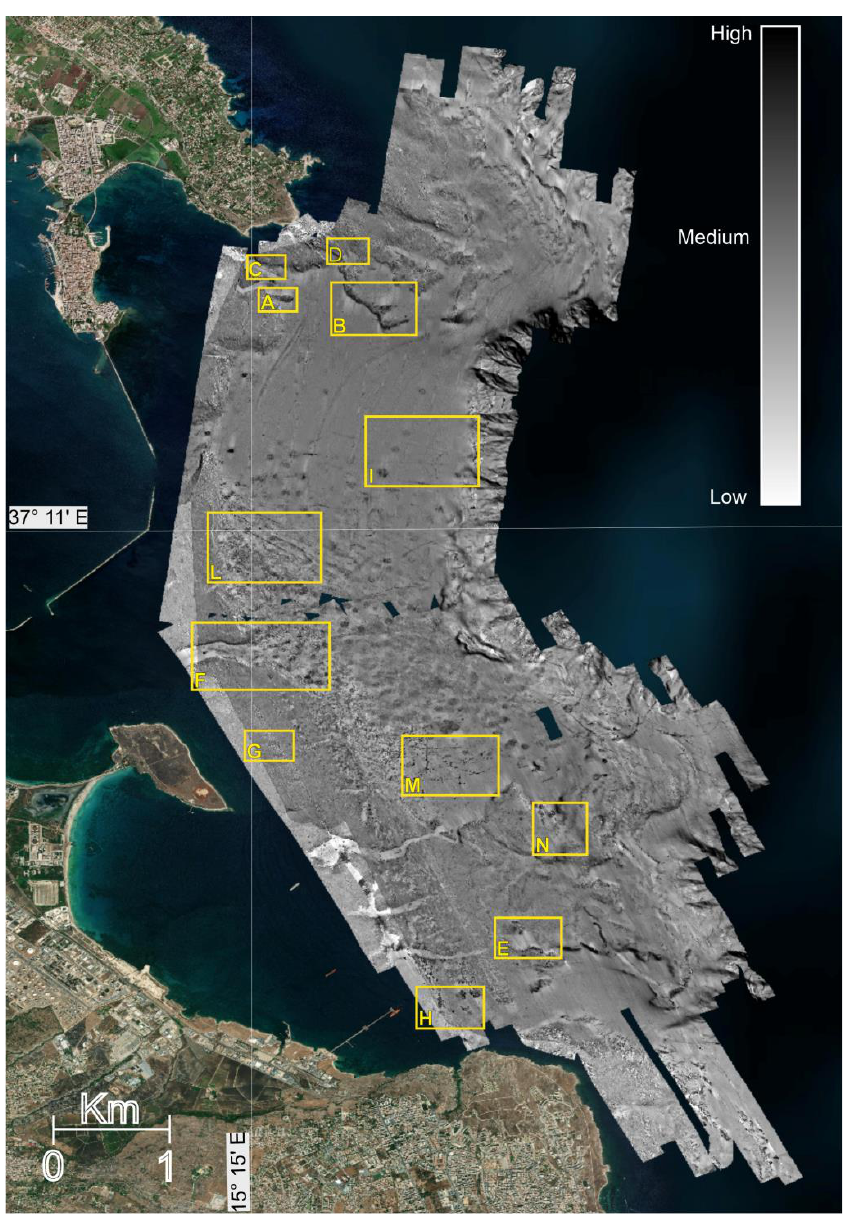
Figure 2. Mosaicked SSS images (1 m pixel resolution) of Augusta Bay covering the shelf sector from about 20 to 250 m bsl. The image was draped over the DEM (where present) to highlight correspondence between seabed morphologies and backscatter. Yellow boxes show the location of images in the ensuing figures. Scalebar indicates the backscatter.